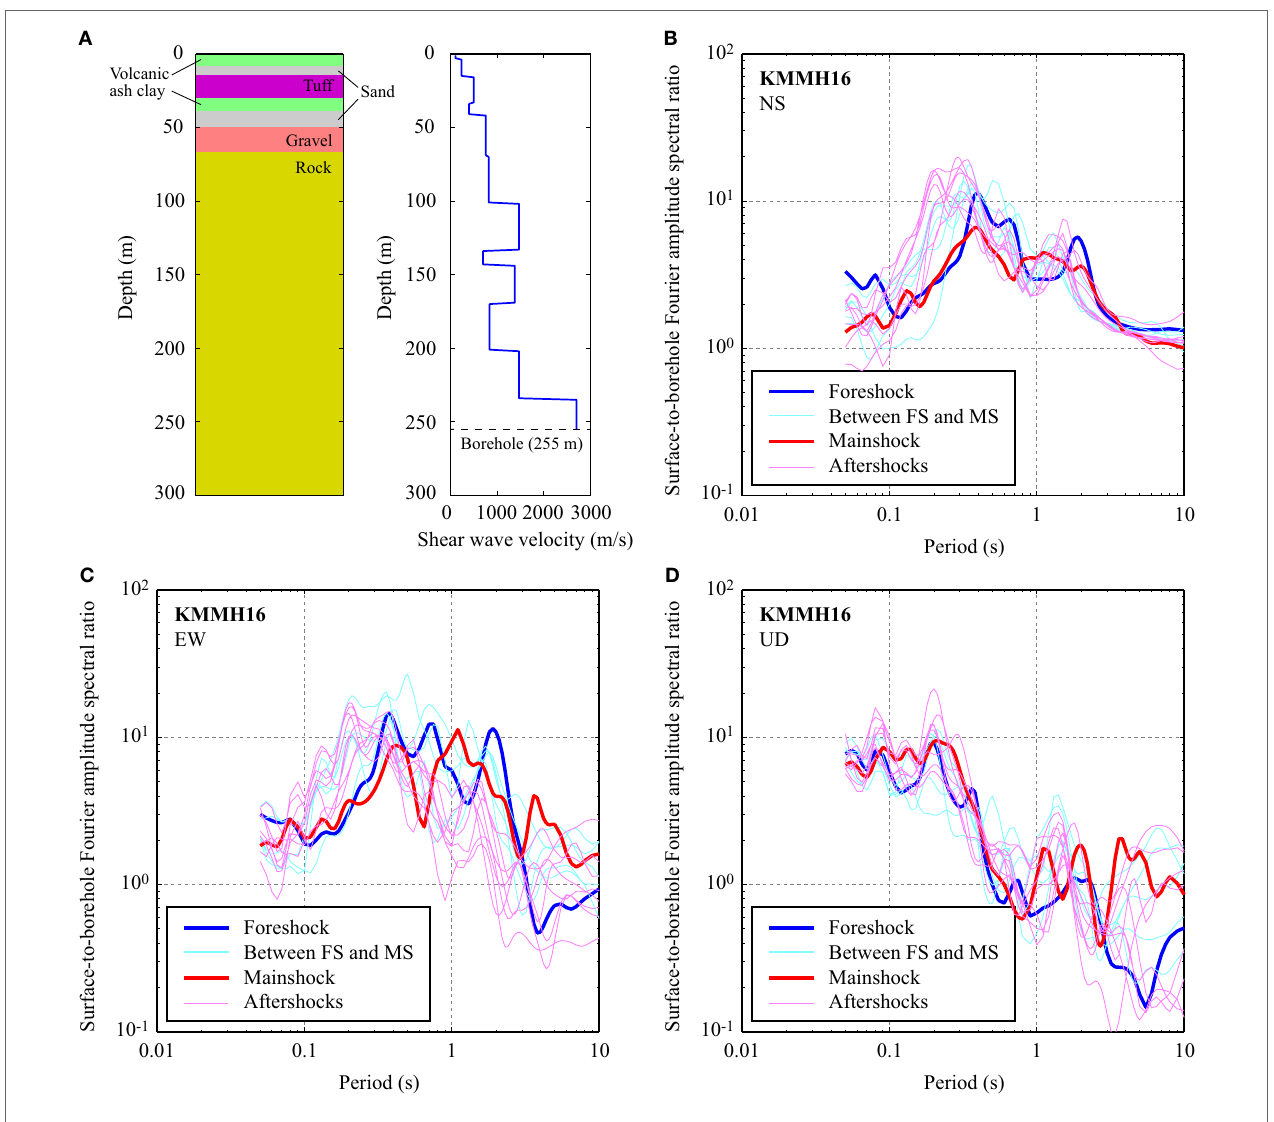
FigUre 7 | (a) Borehole log and shear wave velocity profile at KMMH16. Surface-to-borehole ratios of Fourier amplitude spectra at KMMH16 for different earthquakes during the 2016 Kumamoto foreshock–mainshock–aftershock sequence: (B) NS components, (c) EW components, and (D) UD